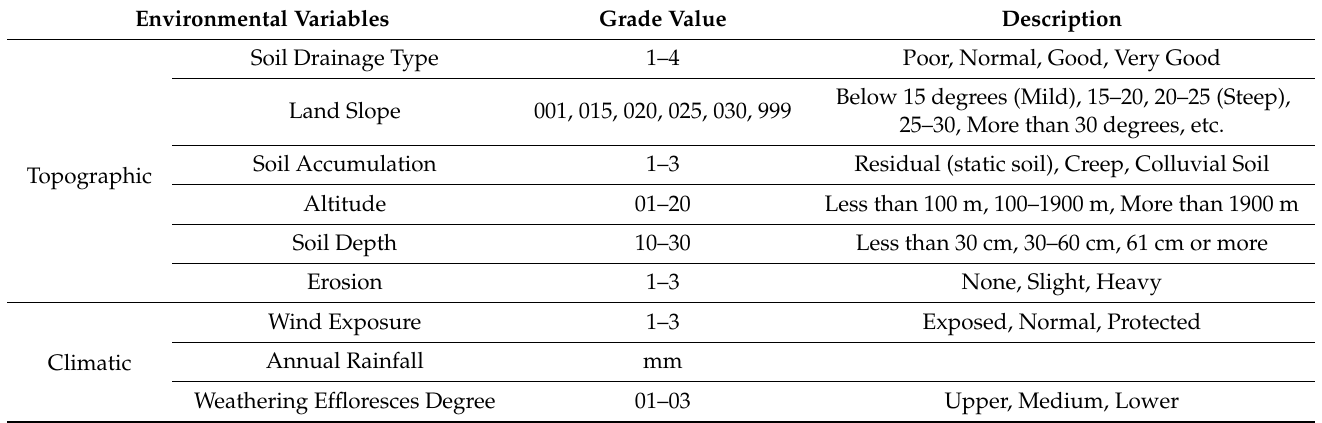
Table 1. Environmental variables implemented.